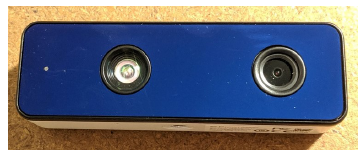
Table 1. Resolution of the information provided as outputs by Pico Zense DCAM710 camera.